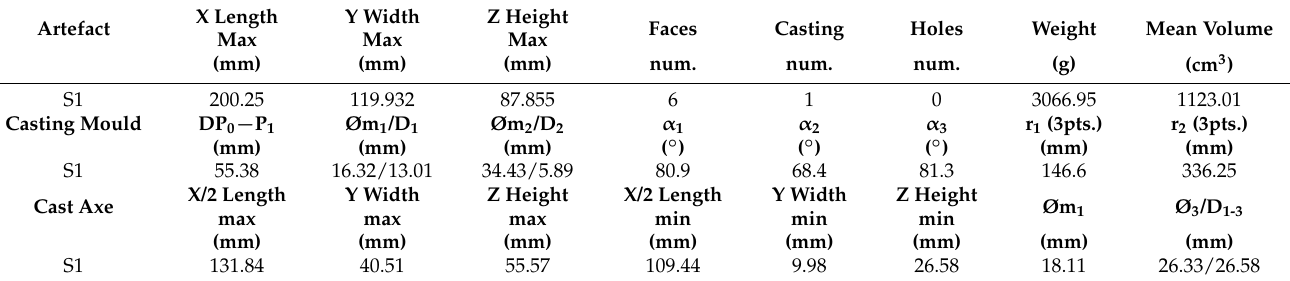
Table 9. Morphometric analysis through 3D model of S1